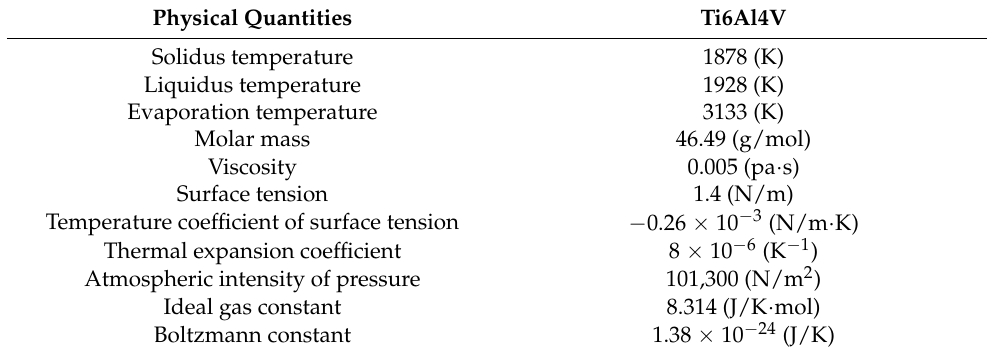
Table 1. Material parameters setting for simulation in fluid flow and heat transfer.